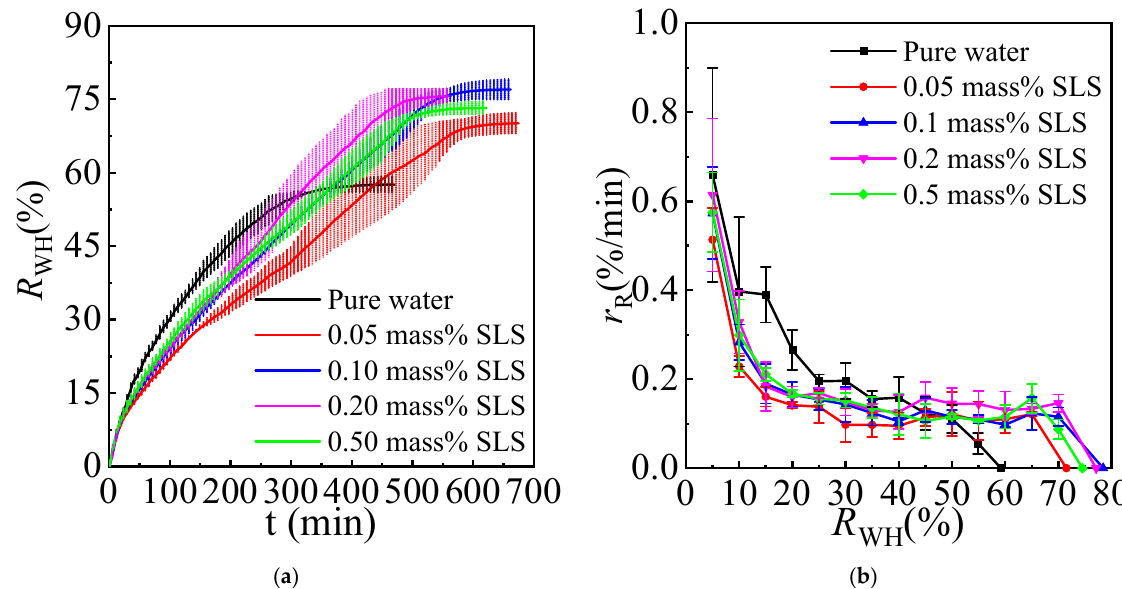
Figure 4. The kinetic data of the hydrate formation with different w p,0 at 278.15 K under 1.24 MPa: ( a ) R WH vs. time; ( b ) r R vs. R WH .